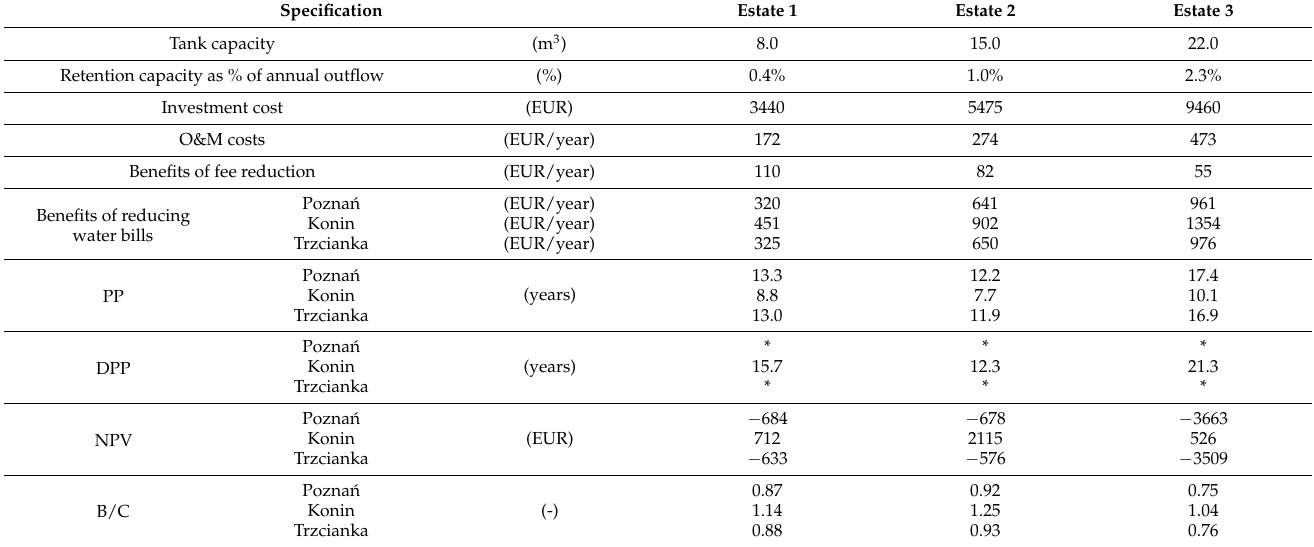
Table 11. Cost-effectiveness of the RWH